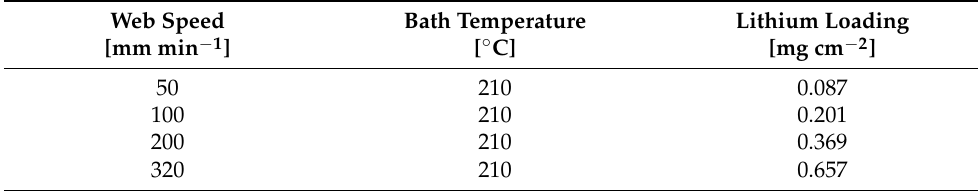
Table 1. Parameters lithium melt